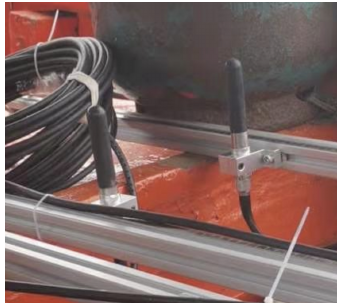
Figure 4. RHSA-10